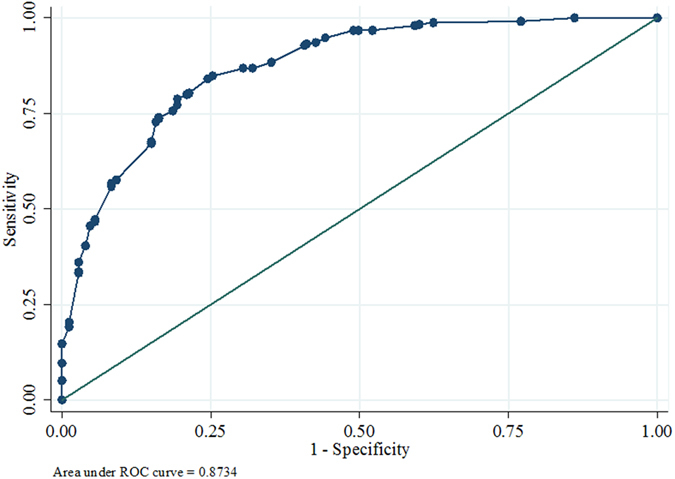
A ROC curve showing area under the curve 0.8734 for CAD cases.